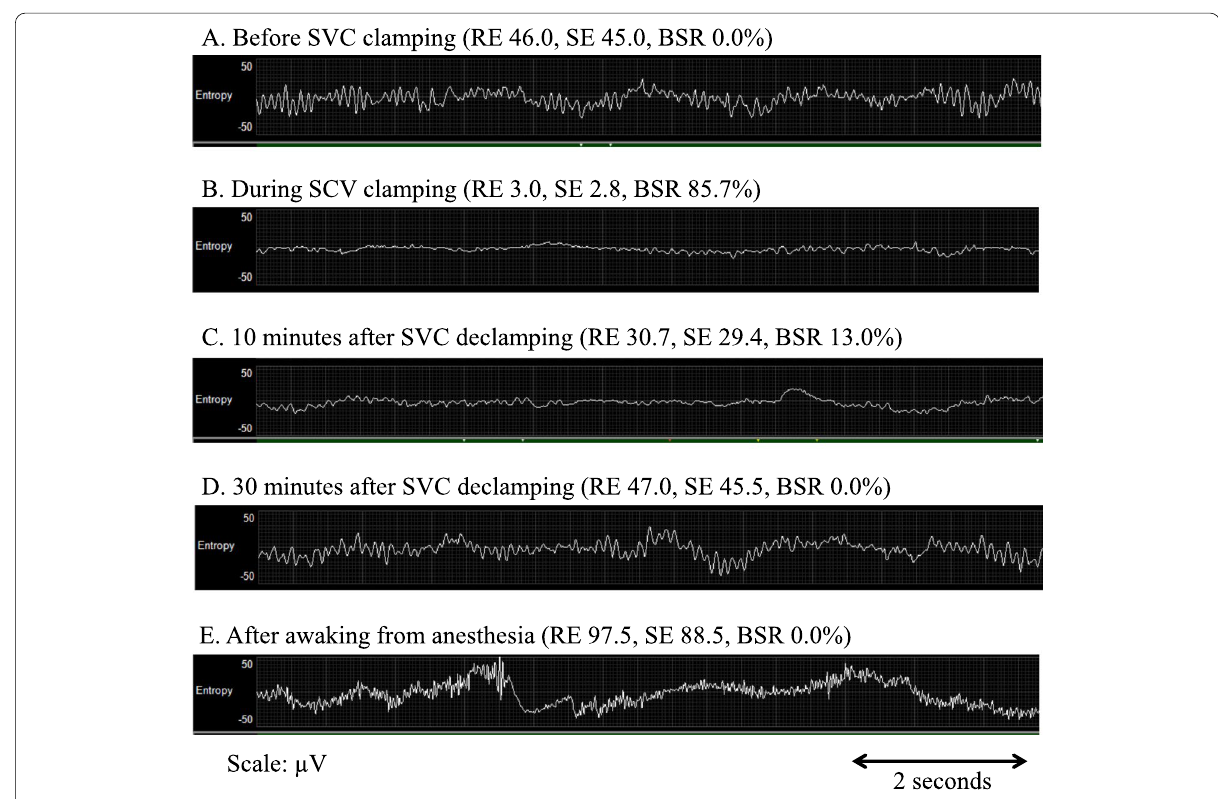
Fig. 2 Electroencephalogram before and after superior vena cava (SVC) clamping. This figure shows the electroencephalogram before and after the SVC clamping. The vertical axis indicates amplitude (μV). The horizontal axis indicates the time, and the arrow scale means 2 s. A Before SVC clamping; α waves and Θ waves are mixed. B During SCV clamping; brain waves disappear and flatten. C Ten minutes after SVC declamping; brain waves remain flat. D Thirty minutes after SVC declamping; the brain wave recovers, and the waveform is the same as before the clamp. E After awaking from anesthesia; β wave, which is an awakening wave, appears. The values of response entropy (RE), state entropy (SE), and burst suppression ratio (BSR) are